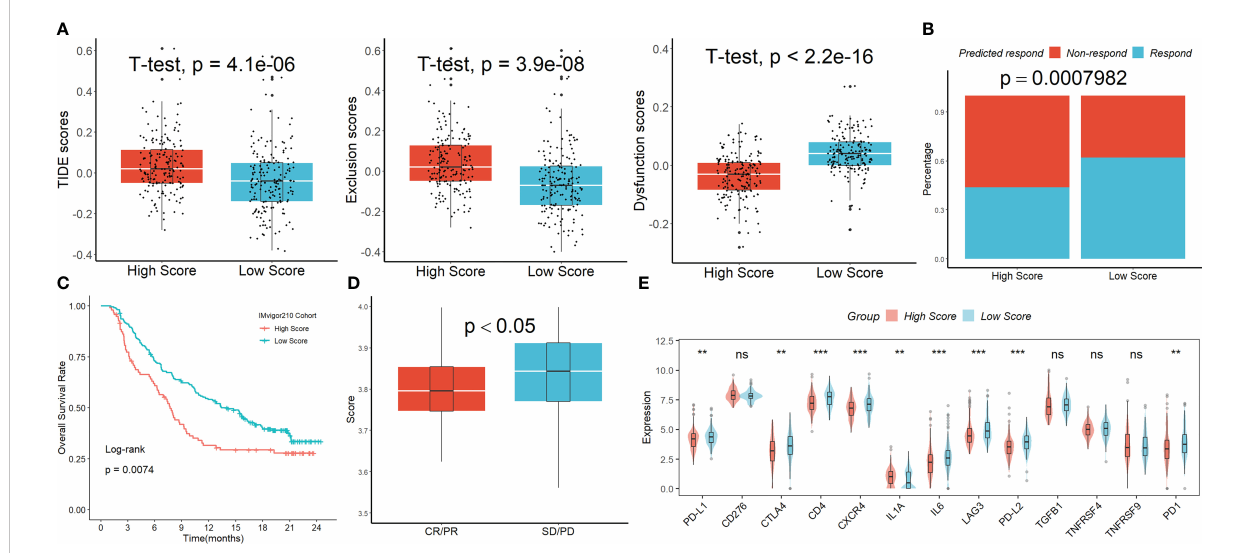
FIGURE 6 The signature ’ s response to PD-L1 blockade immunotherapy. (A) The TIDE analysis. (B) When the projected immunotherapy response rate was included, the proportion of “ respond ” was lower in the high-risk group. (C) In comparison to the high-scoring group, patients in the low-scoring group saw notable clinical bene fi ts and considerably longer overall life in the IMvigor210 cohort. (D) Patients with PD/SD had greater risk ratings than those who had a complete response CR/PR. (E) The expression levels of the ICIs genes in the two groups. ns, not signi fi cant; **p <0.01; ***p <